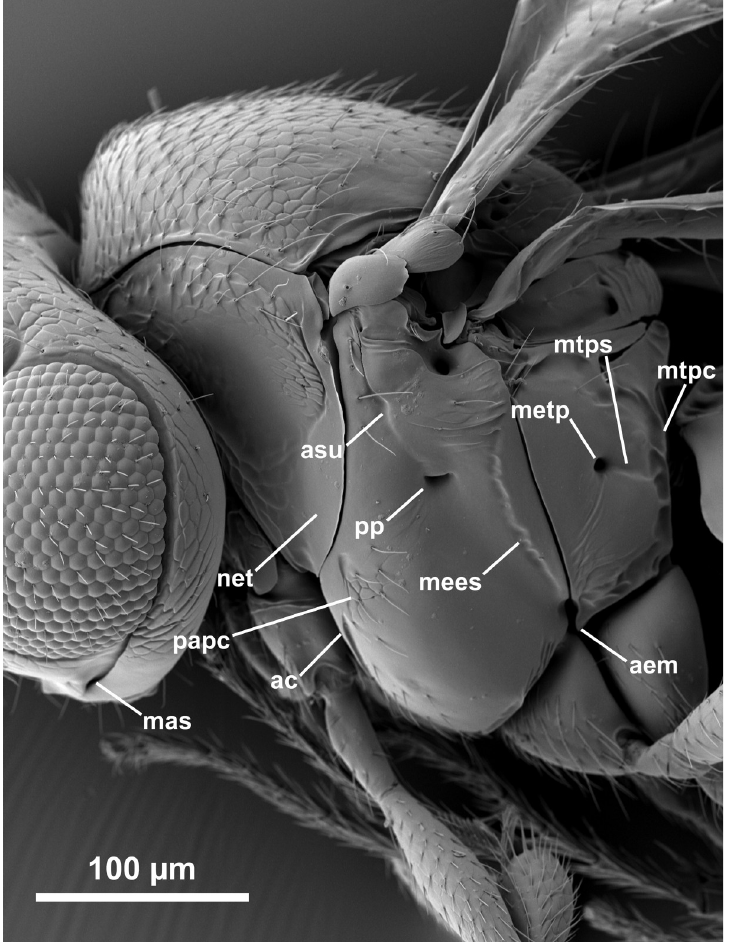
Fig 6. Telenomus nizwaensis Polaszek male paratype. Dorsal mesosoma.